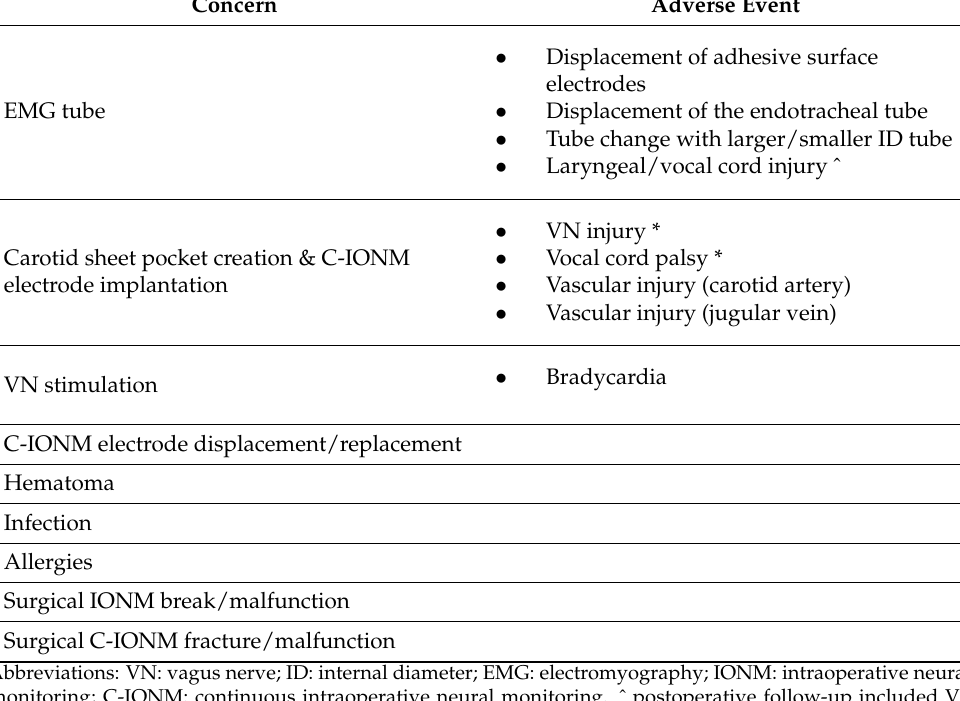
Table 2. Adverse event